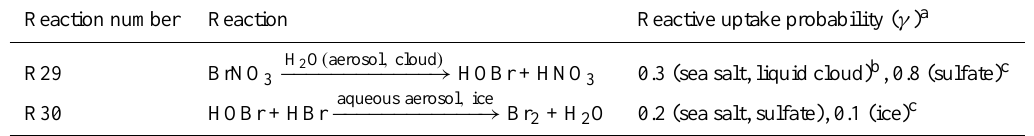
Table 2d. Tropospheric bromine chemistry in GEOS-Chem: heterogeneous processes.